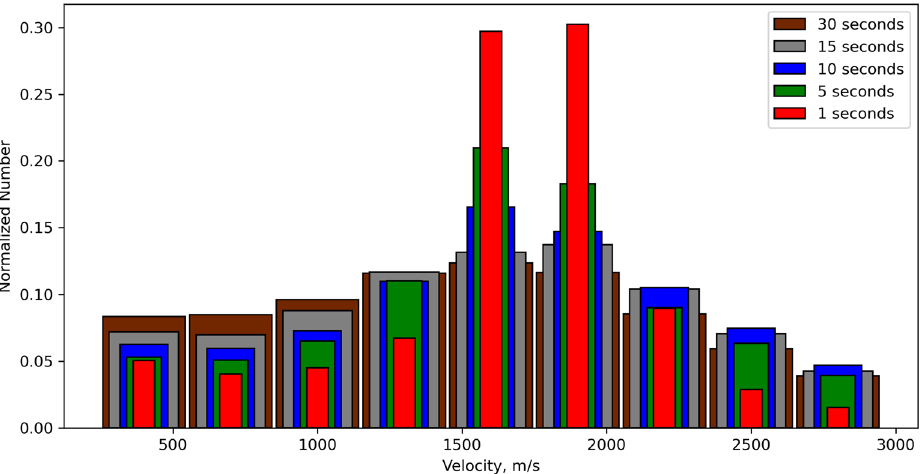
Figure 10. Distribution of velocity values calculated from data of different temporal cadences: 1-(red), 5-(green), 10-(blue), 15-(gray), 30-(brown)